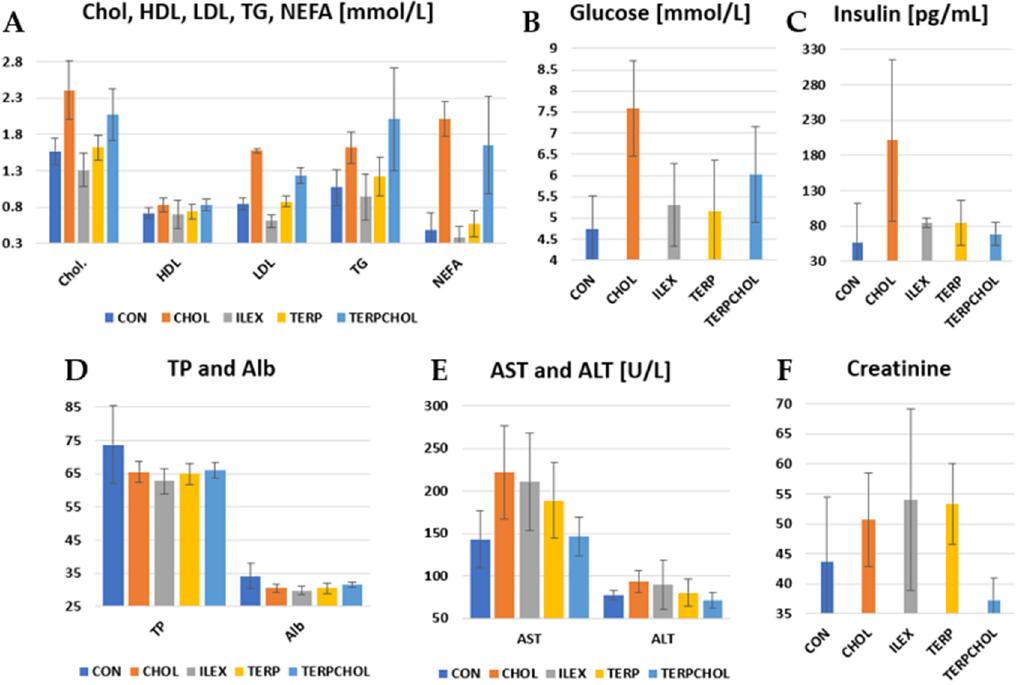
Figure 3. Levels of ( A ) Chol., HDL, LDL, TG and NEFA; ( B ) glucose; ( C ) insulin; ( D ) TP and Alb.; ( E ) AST and ALT and ( F ) creatinine in the CON, CHOL, ILEX, TERP, and TERPCHOL groups.